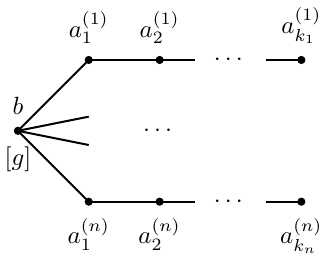
(cid:0) (cid:1) q i n b; g ; i =1 p i g f